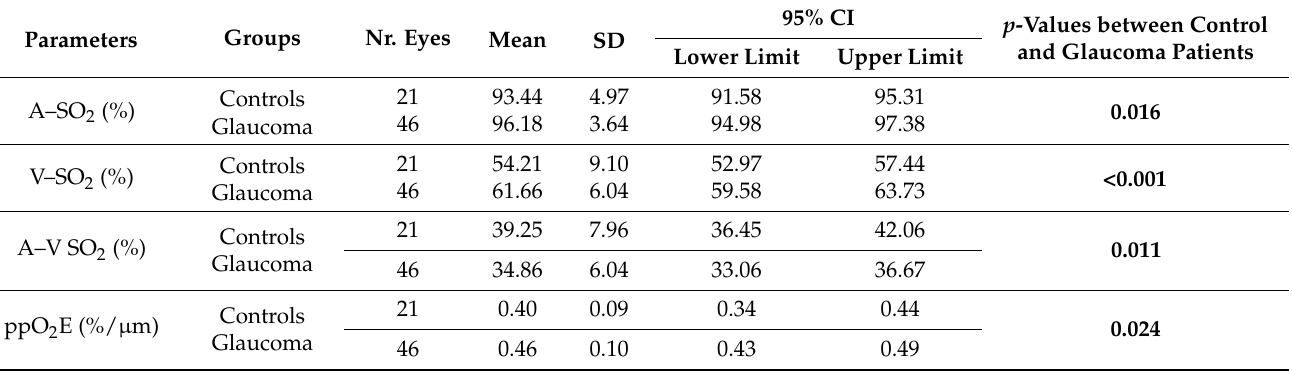
Table 1. Oxygen saturation values (%) and peripapillary oxygen exposure values (ppO 2 E; %/ µ m)